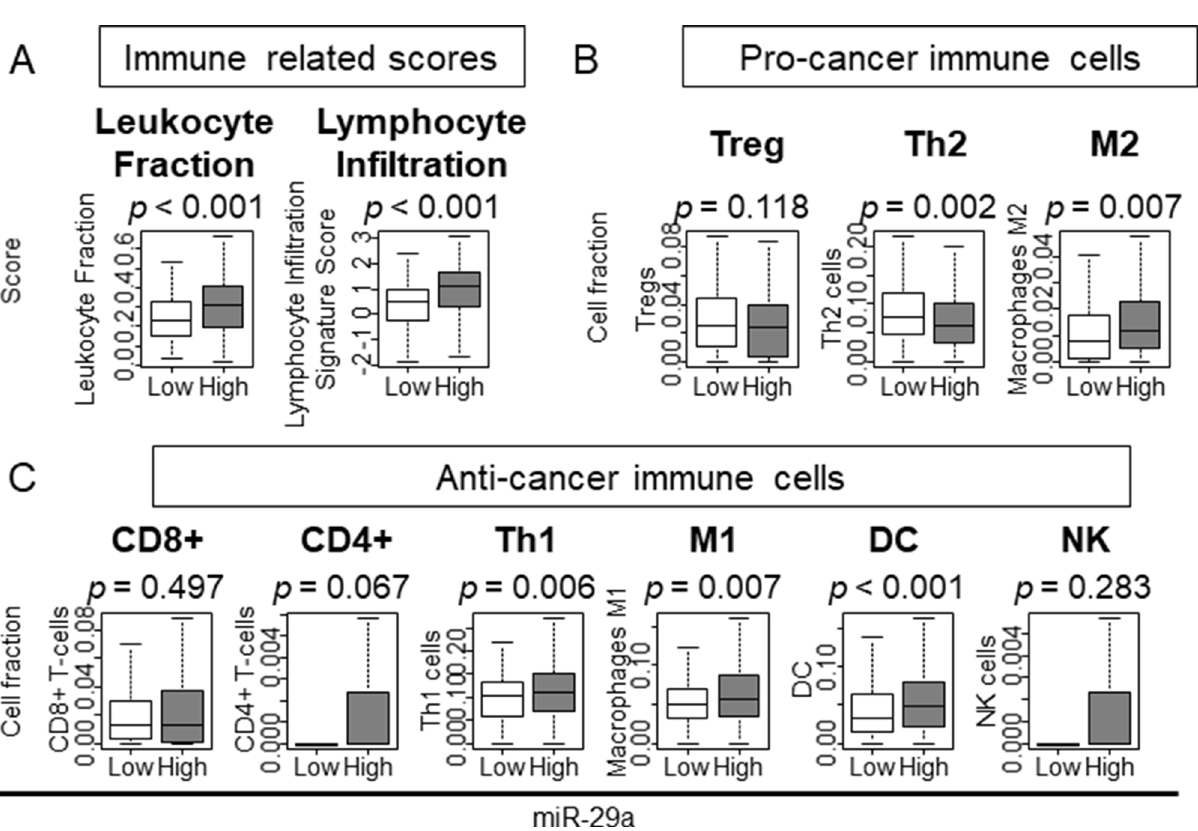
Figure 4. The association between miR-29a and immune related scores or infiltrated immune cells within immune tumor microenvironment ( A ) The association between miR-29a and immune related scores. ( B ) The association between miR-29a and pro-cancer immune cells. ( C ) The association between miR-29a and anti-cancer immune cells. CD4+ CD4 positive T cell, CD8+ CD8 positive T cell, DC dendritic cells, M1/2 Macrophage M1/M2, NK natural killer cells, Th1/2 type 1/2 helper T cell, Treg regulatory T cell; The statistical significance was defined by p < 0.05. Tukey-type boxplots demonstrate median and inter-quartile level